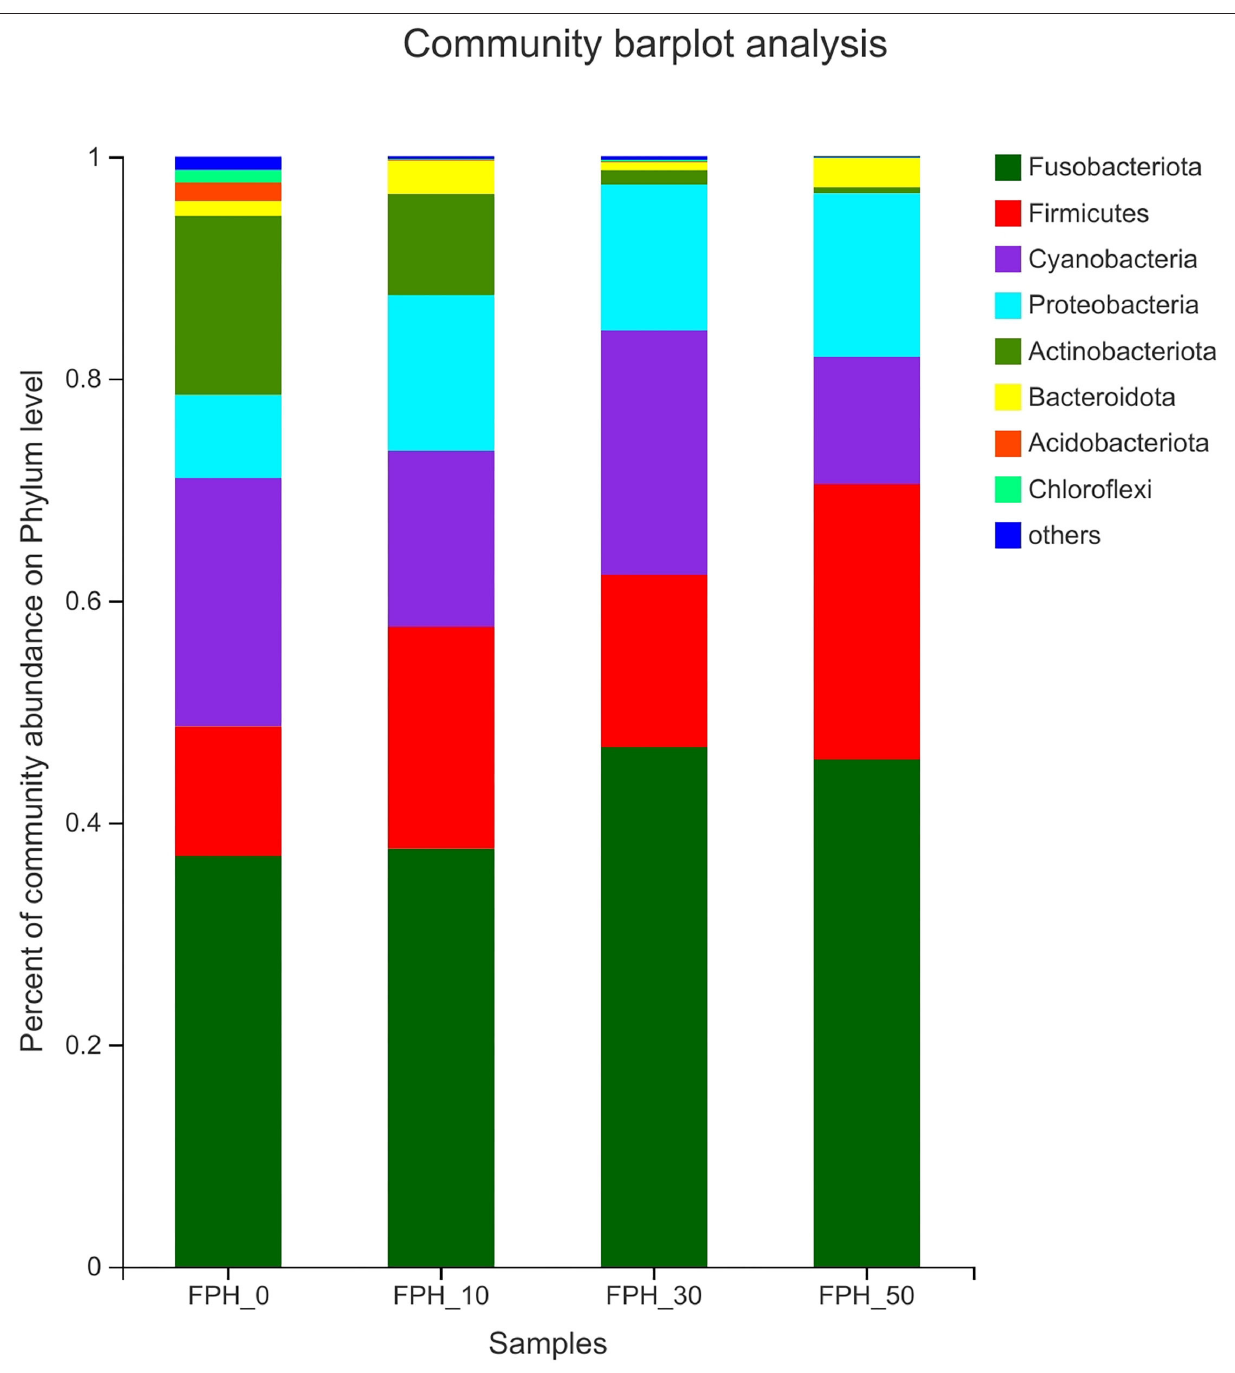
bass (63). This suggests that FPH also modulates the immune response of fish through regulating the expression of